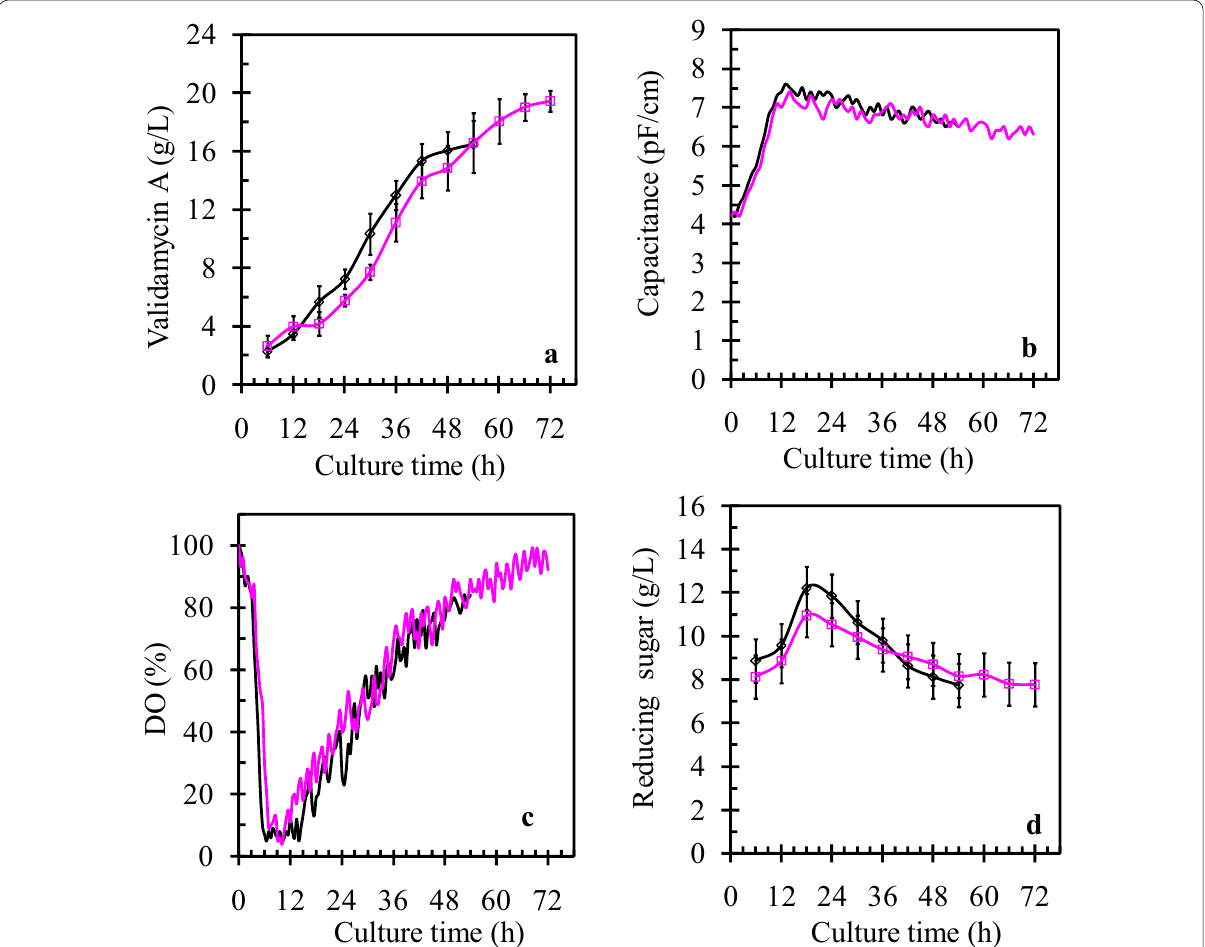
Fig. 2 Time courses of validamycin A batch fermentation with Ion-exchange wastewater in 50-L bioreactor by S. hygroscopicus K18 (black line) and K2509 (red line): a profiles of validamycin A, b profiles of capacitance measurement in broth, c profiles of reducing sugar concentration, and d profiles of